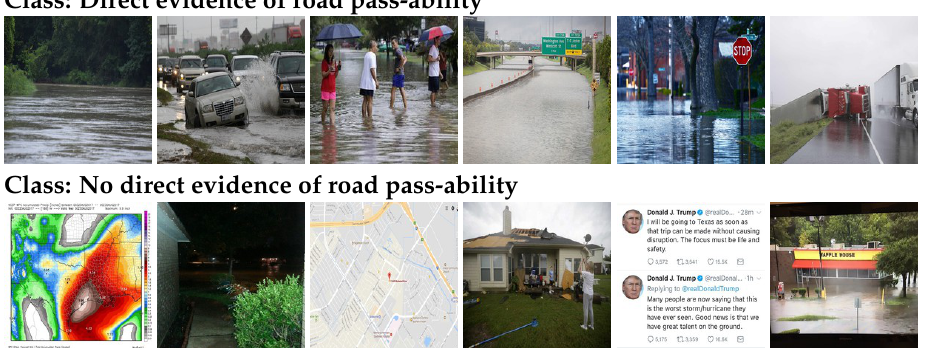
Figure 4. FCSM Dataset: Random images of “Route” and “No Route” classes.